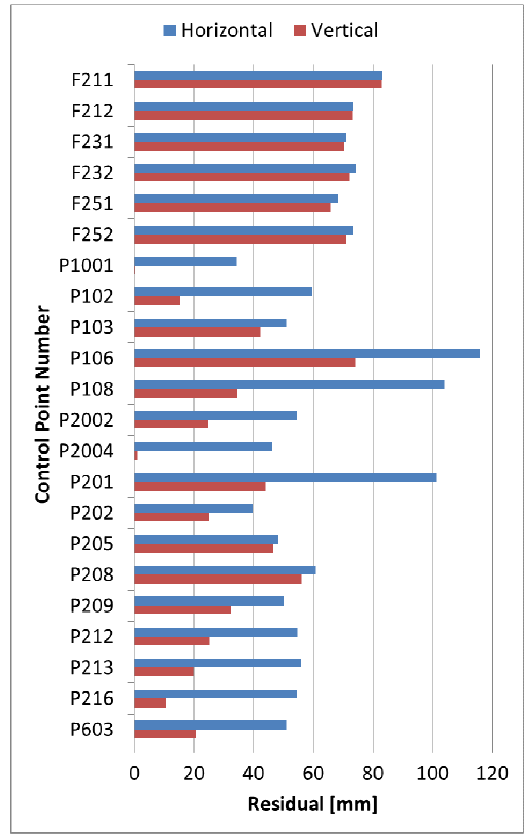
Figure 5. Residuals calculated from comparing aligned and georeferenced Geo-X8000 data to a control